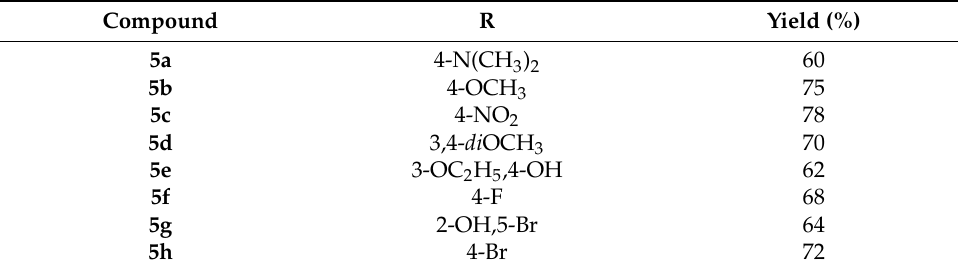
Table 1. Synthesis of derivatives 5a – h